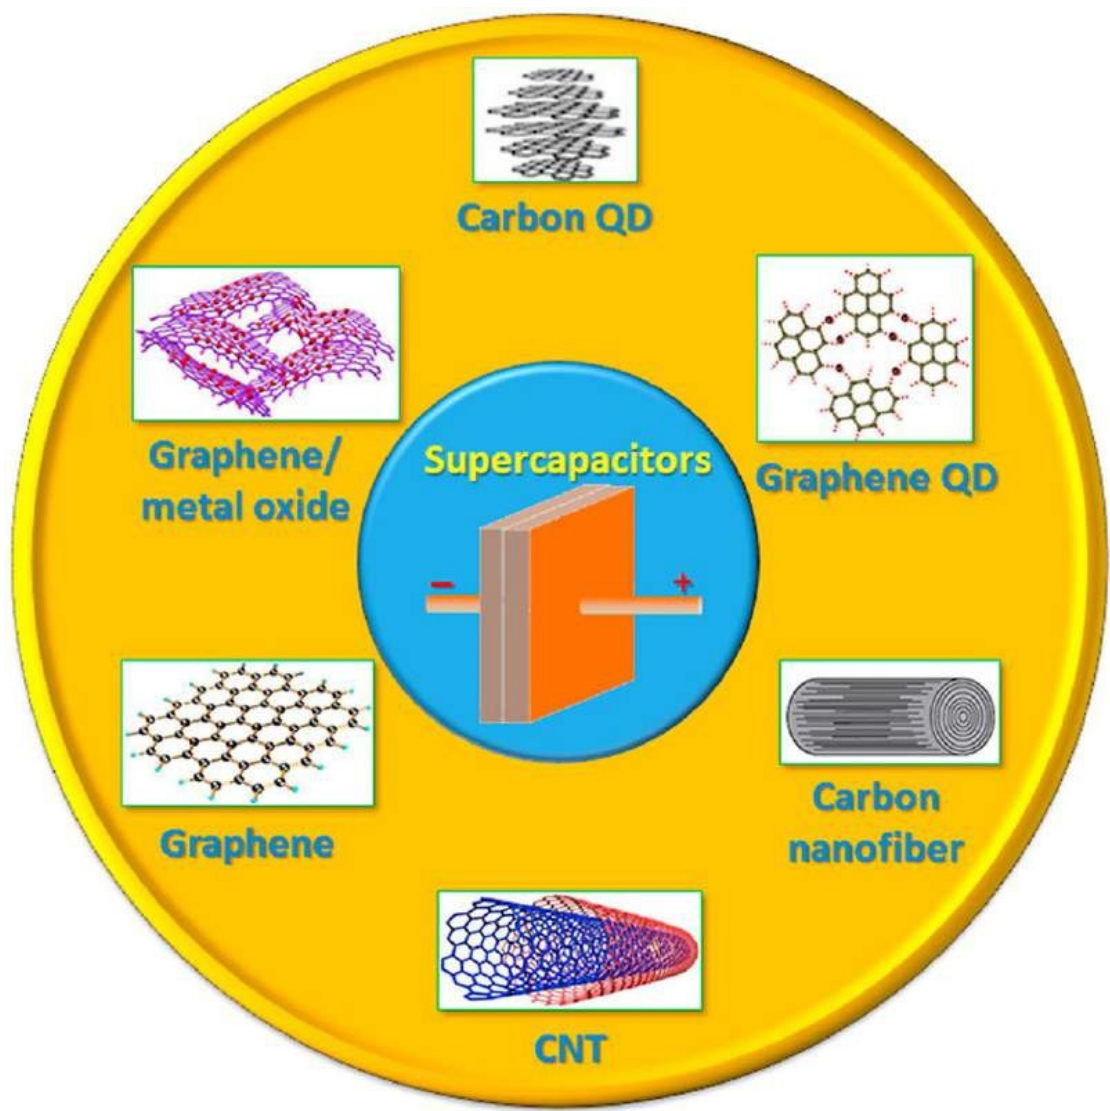
Figure 2. One- to two-dimensional nanostructured carbon-based materials. Reproduced with permission from [49].